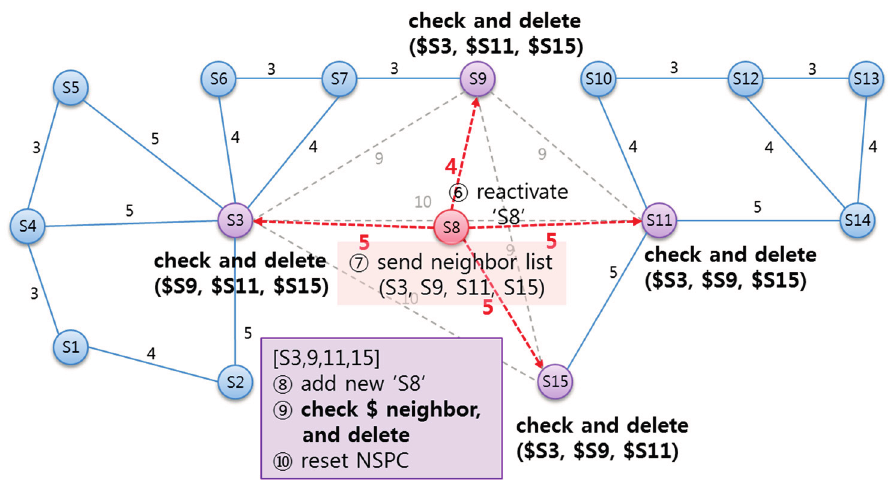
Figure 15. The state diagram from reactivation of an existing SLiM Hub after transient